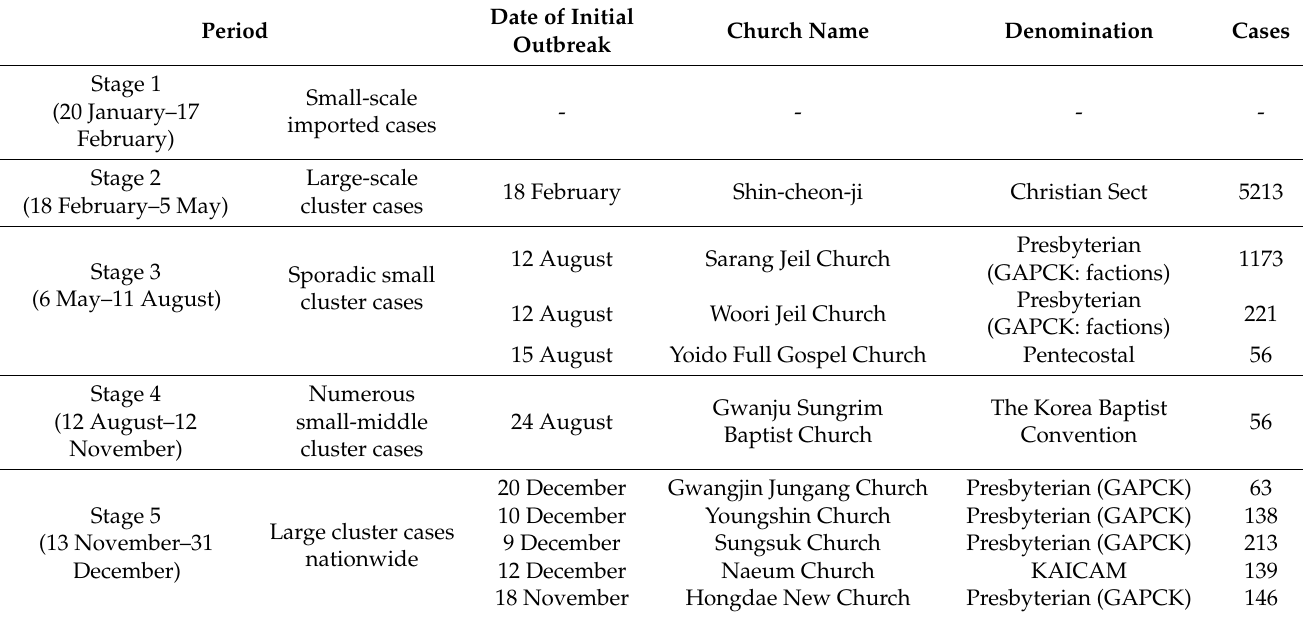
Table 4. Religious facilities linked to 50+ cases of COVID-19 in 2020.